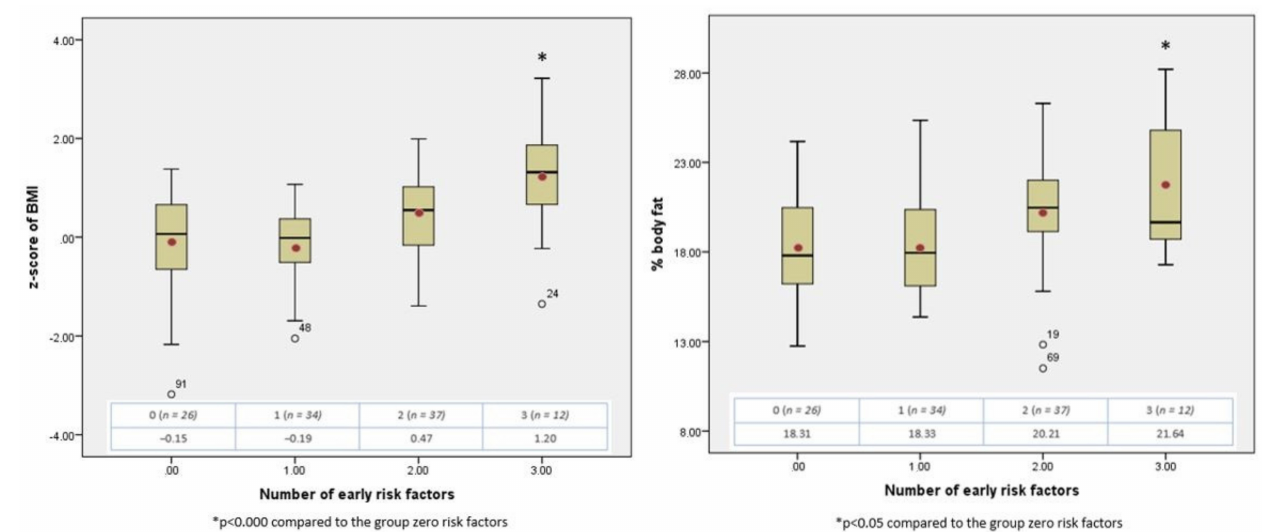
Figure 2. Cumulative effect of early risk factors on BMI z-score and body fat percentage at 2 years. (* indicates significance).